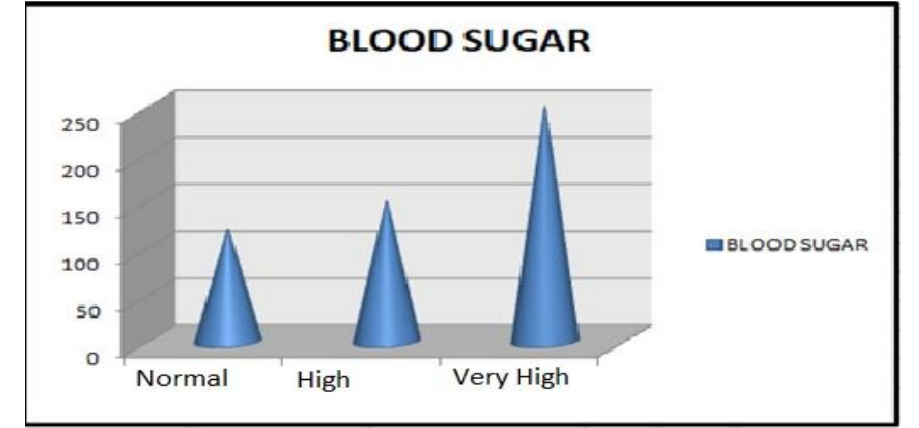
Figure 3. Chest pain levels.